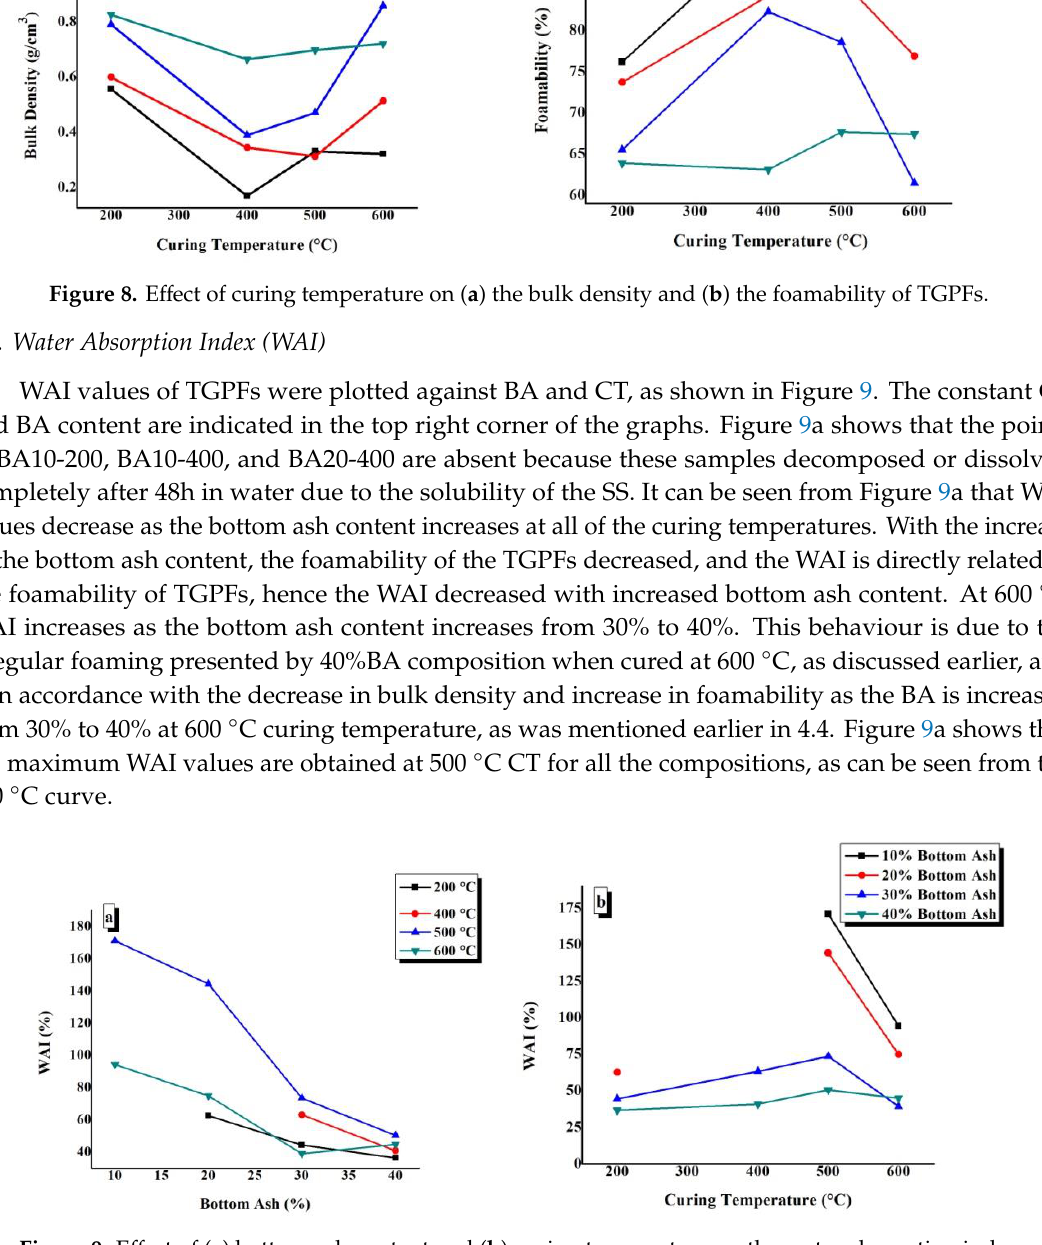
Figure 7. Effect of bottom ash content on ( a ) bulk density and ( b ) foamability of TGPFs.